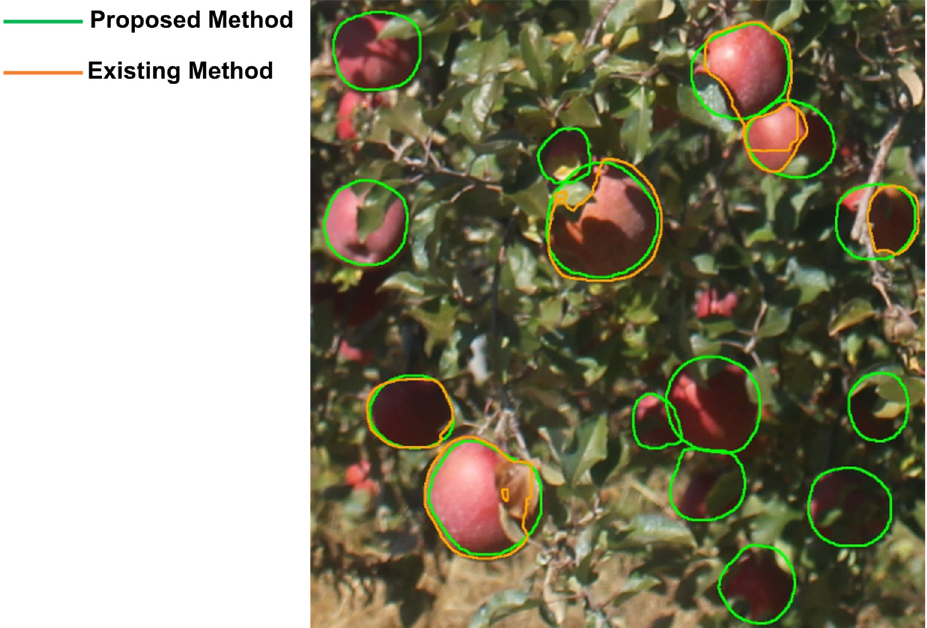
Figure 12. Example of hidden fruit detection. The proposed model can accurately detect hidden regions caused by fruit leaves, branches, and shadows. The orange line is the result of the COCO as an existing method, and the green line is the result of the proposed method.